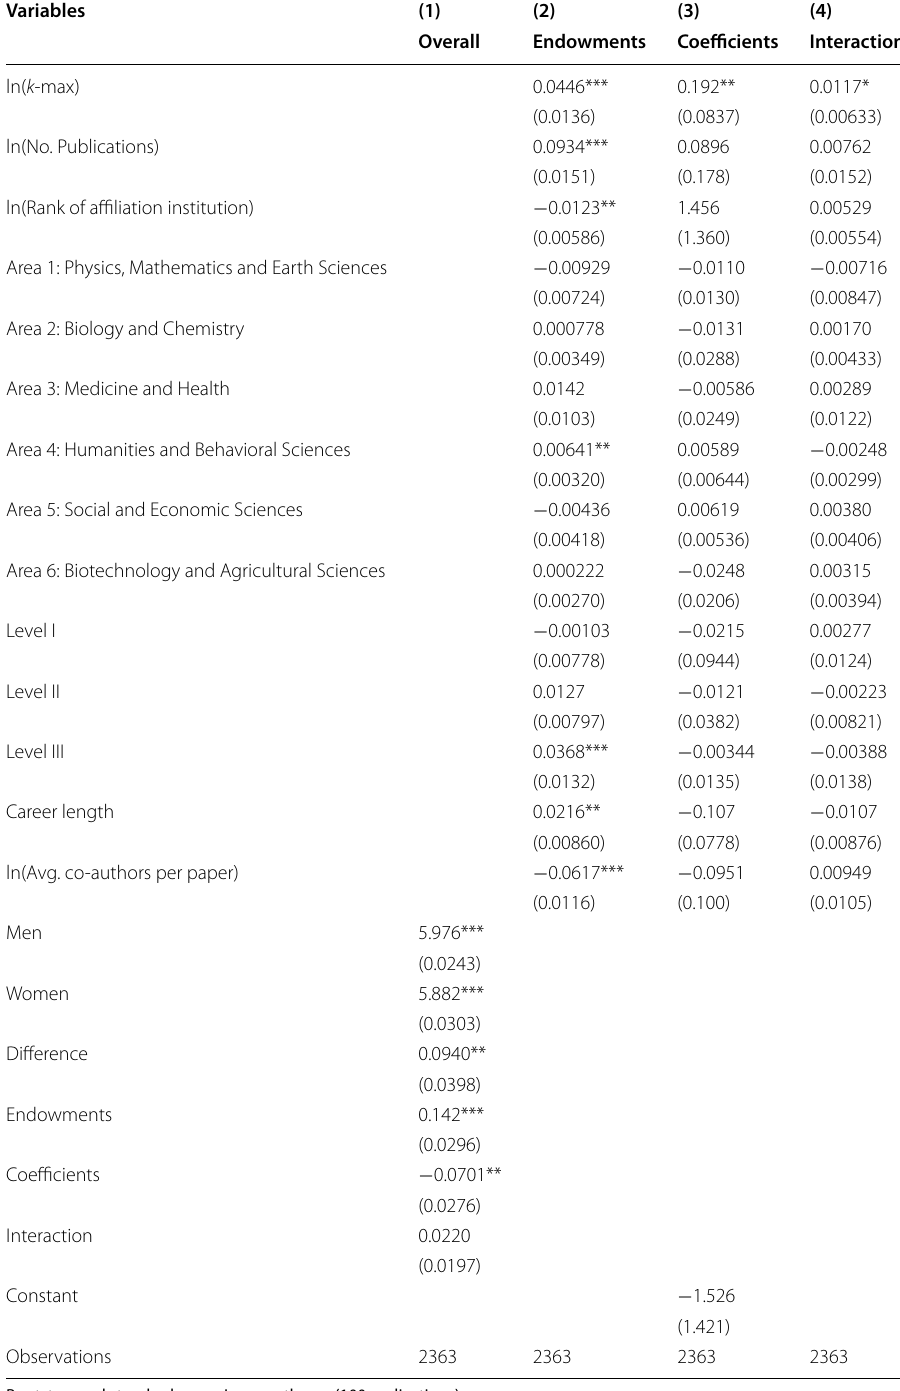
Table 4 Blinder–Oaxaca